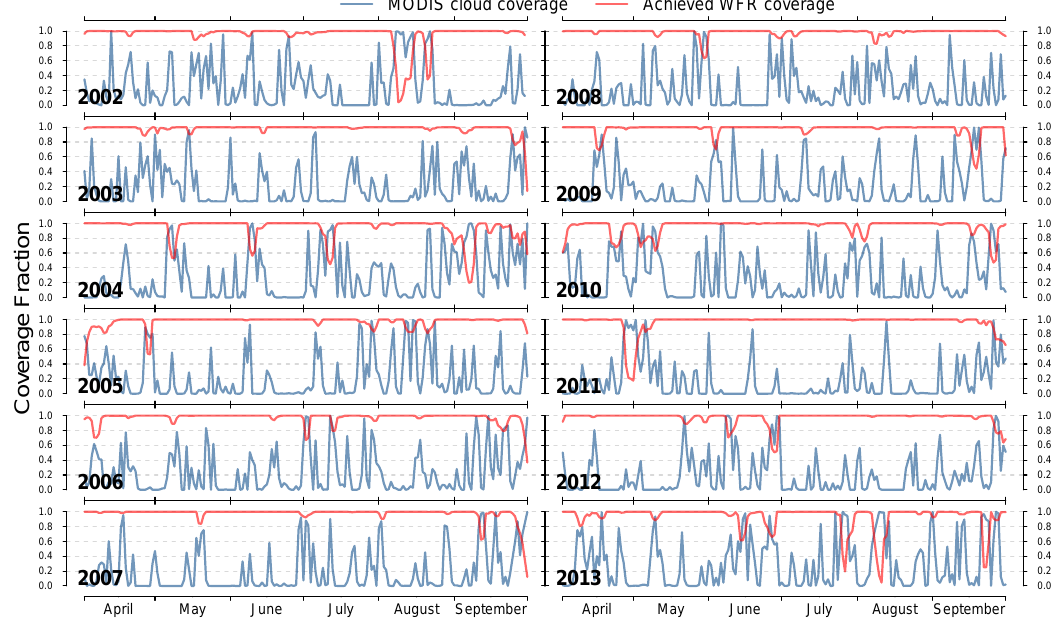
Figure 7. Present MODIS cloud coverage for the Brunt Ice Shelf region (blue line) and the maximum achieved coverage using WFR -CMB1 (red line) in decimal cover fraction. 6 d The WFR -CMB1 approach adds an average of 2433 km 2 of potentially missed POLA due to 6 d cloud-affected